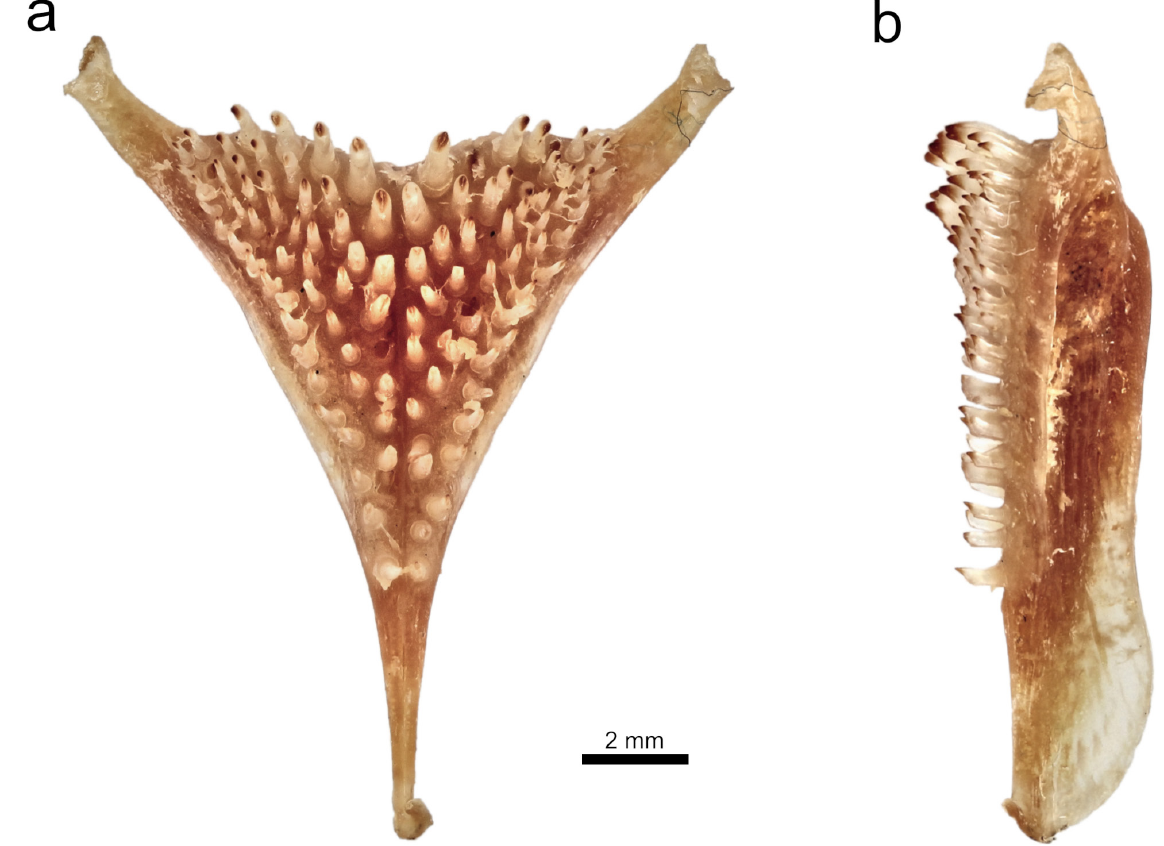
Fig. 10. Haplochromis mentatus Regan, 1925 (RMCA 2018.008.P.0389; 137.1 mm SL). a . Dorsal view of the lower pharyngeal jaw. b . Lateral view of the lower pharyngeal